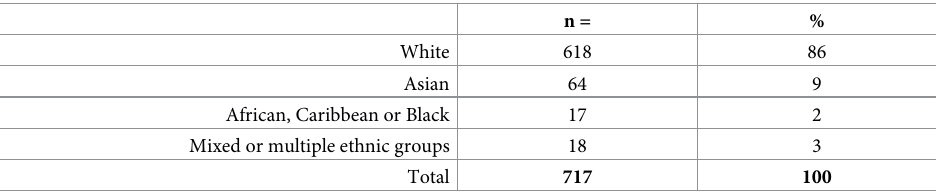
Table 5. Response rate comparison of ethnicity across ERN